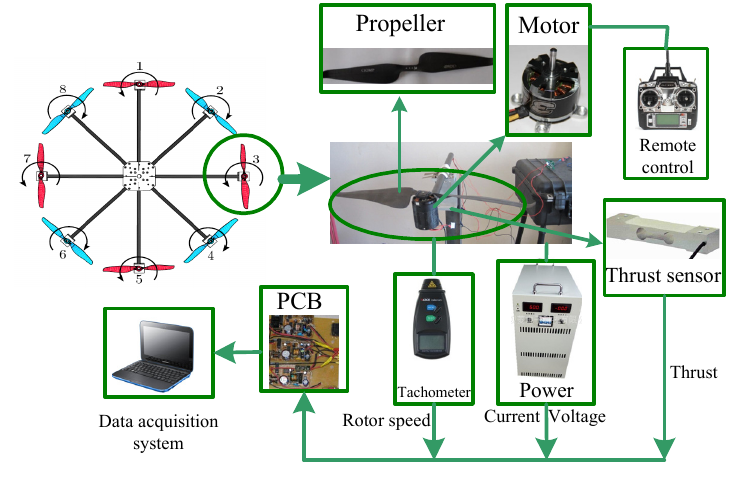
Figure 2. Schematic diagram of test bench.